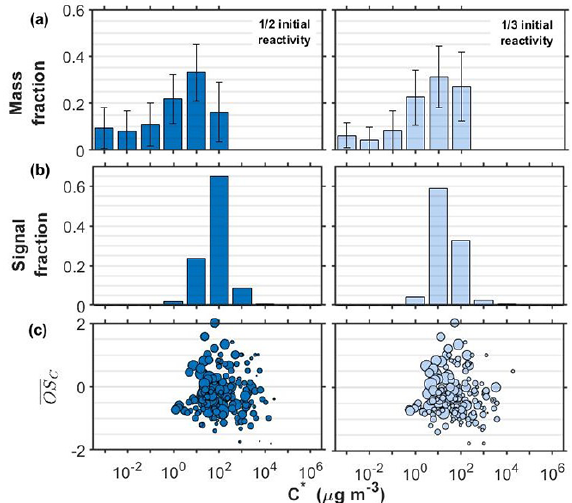
Figure 2. SOA particle volatility distributions from (a) the TD mea- surements ( ± retrieval uncertainty) and (b) the FIGAERO-CIMS measurements in the o -cresol experiments conducted at half initial reactivity. (c) All the products identified by the FIGERO-CIMS are shown as a function of their volatility ( C ∗ ) and their oxidation state (OSc) sized by the square root of their particle-phase